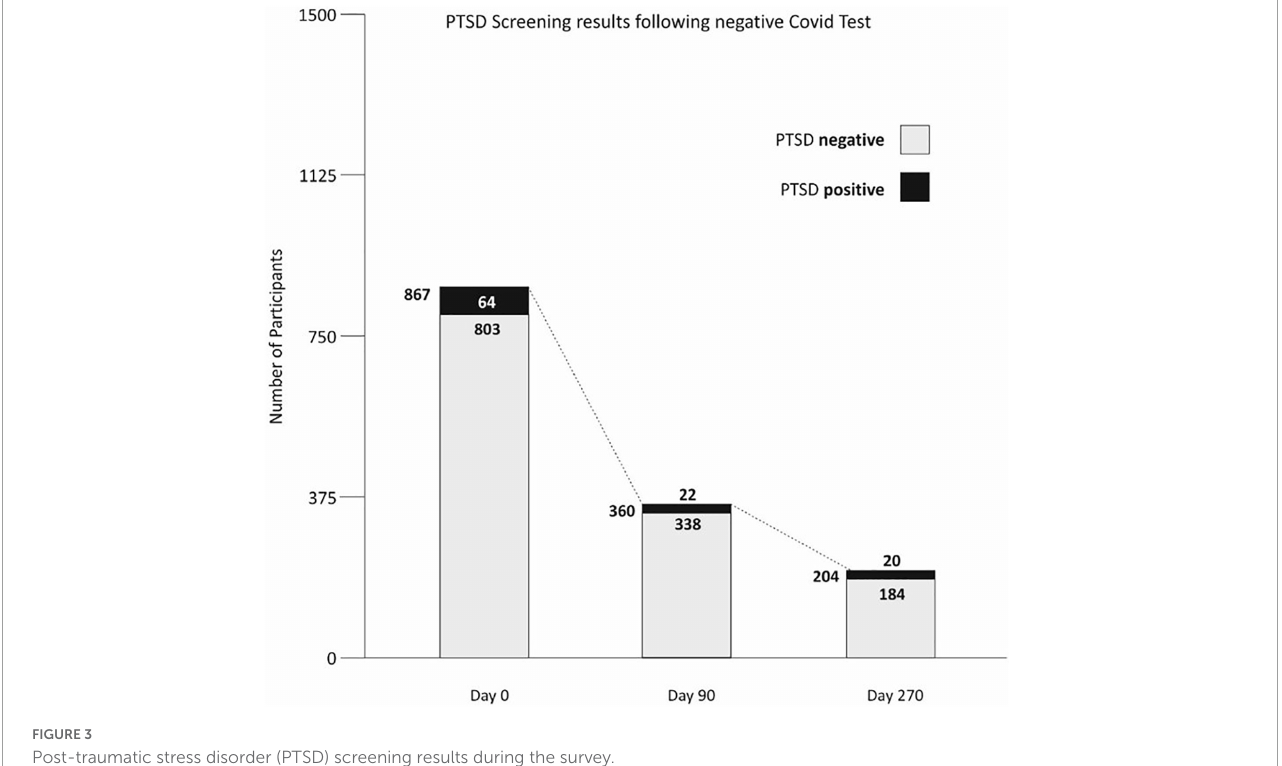
FIGURE3 Post-traumatic stress disorder (PTSD) screening results during the survey.